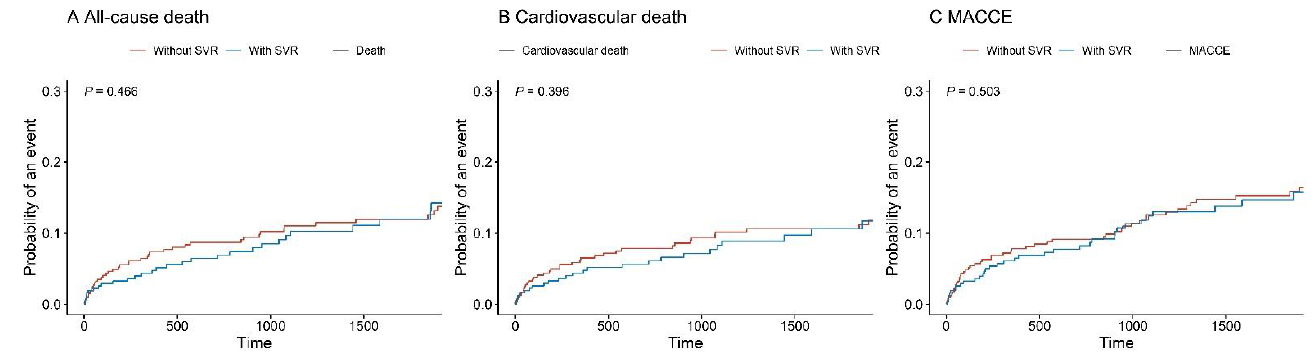
Values are n (%). SVR = surgical ventricular reconstruction. MACCEs = major adverse cardiovascular and cerebrovascular events. CI = confidence interval. PSM = propensity score matching. IPTW = inverse probability of treatment weighting.